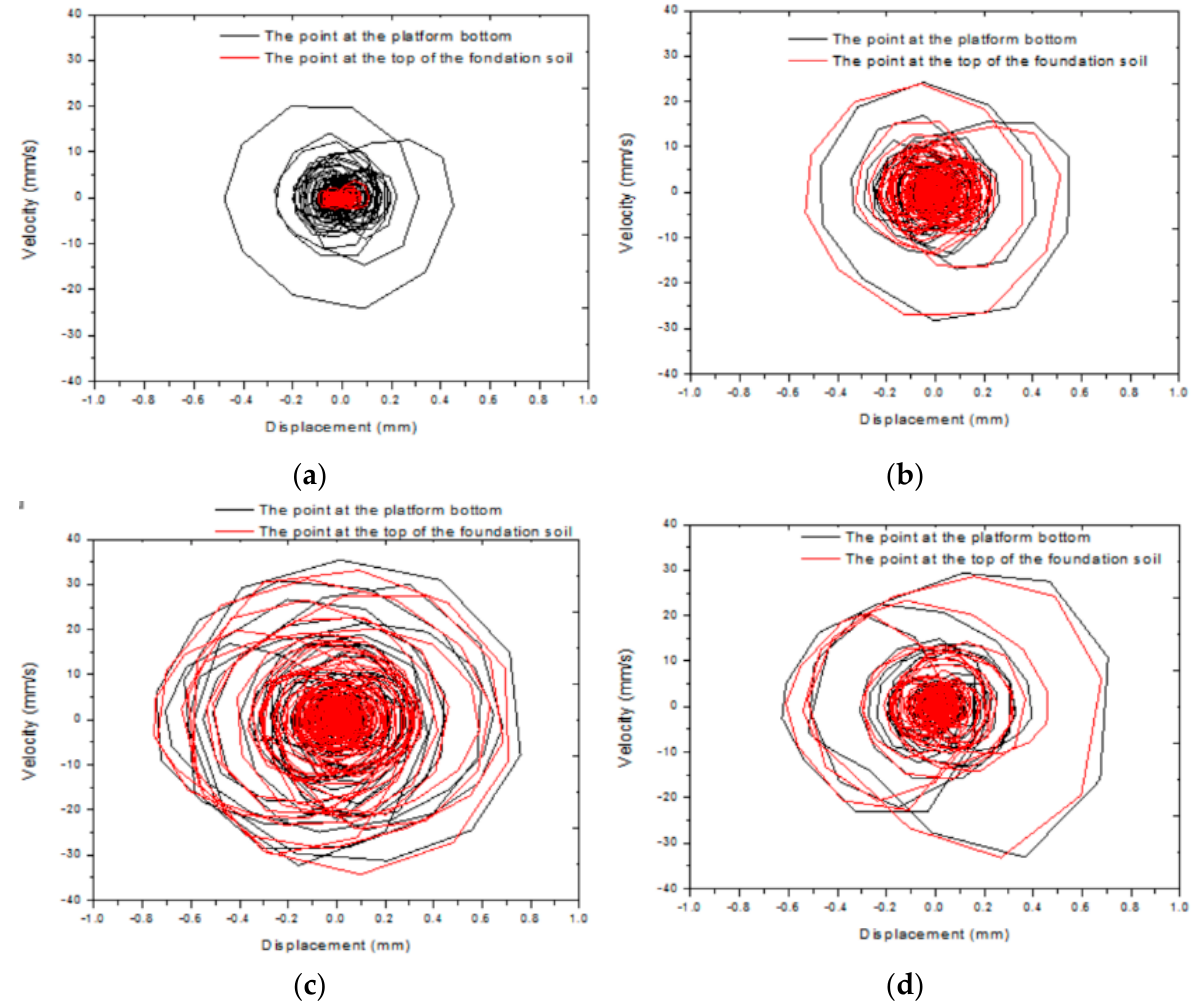
Figure 11. Phase-Plane Curves of “Adjacent” Measuring Points at Soil-Pile Cap Interface under Earthquakes of the Same Small Magnitude: ( a ) S2-1, ( b ) S2-2, ( c ) S3, ( d ) S4.